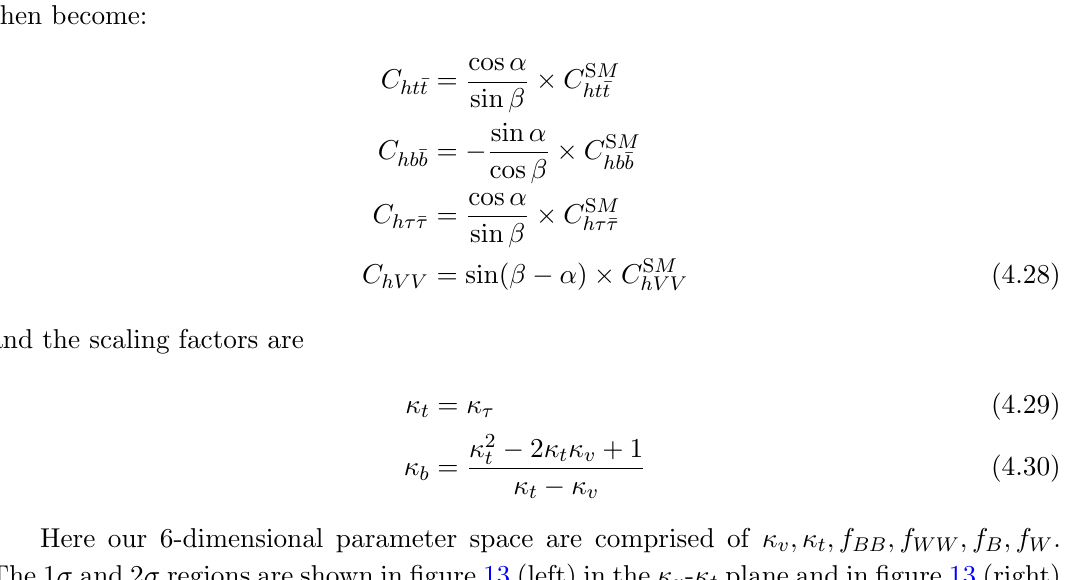
Figure 12 . Allowed regions at 1 (cid:27) (red) and 2 (cid:27) (blue) levels in the parameter space of f ( m g (left) and sin( (cid:12) (cid:0) (cid:11) ) (cid:0) f ( m ) (right) in Lepton-speci(cid:12)c 2HDM. hH + H (cid:0) H (cid:6) Equating the loop contribution to h ! (cid:13)(cid:13) from both the approaches, we plot the 1 (cid:27) and 2 (cid:27) contours in the f ( m )- g plane and sin( (cid:12) (cid:0) (cid:11) )- f ( m H (cid:6) hH + H (cid:0) and (right) respectively. Only the regions corresponding to f ( m hand side of the vertical line and above the horizontal line are allowed, if one demands f ( m ) (cid:21) 80 H (cid:6)